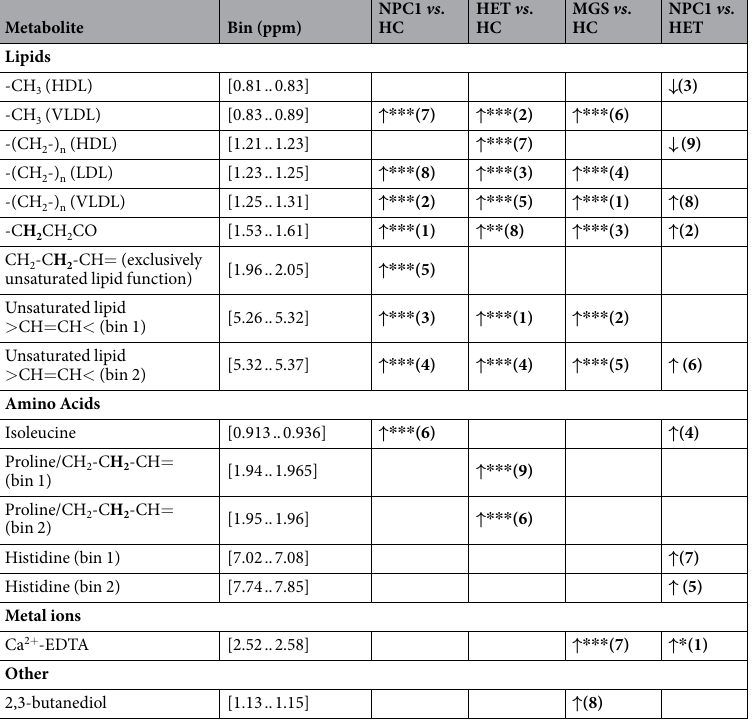
Multivariate techniques are unable to distinguish between MGS-treated and untreated NPC1 patient plasma NMR metabolic profiles. Since MGS is currently the only EMA approved therapy for the treatment of NPC1 disease, we therefore investigated if treatment with MGS gave rise to changes to the 1 H